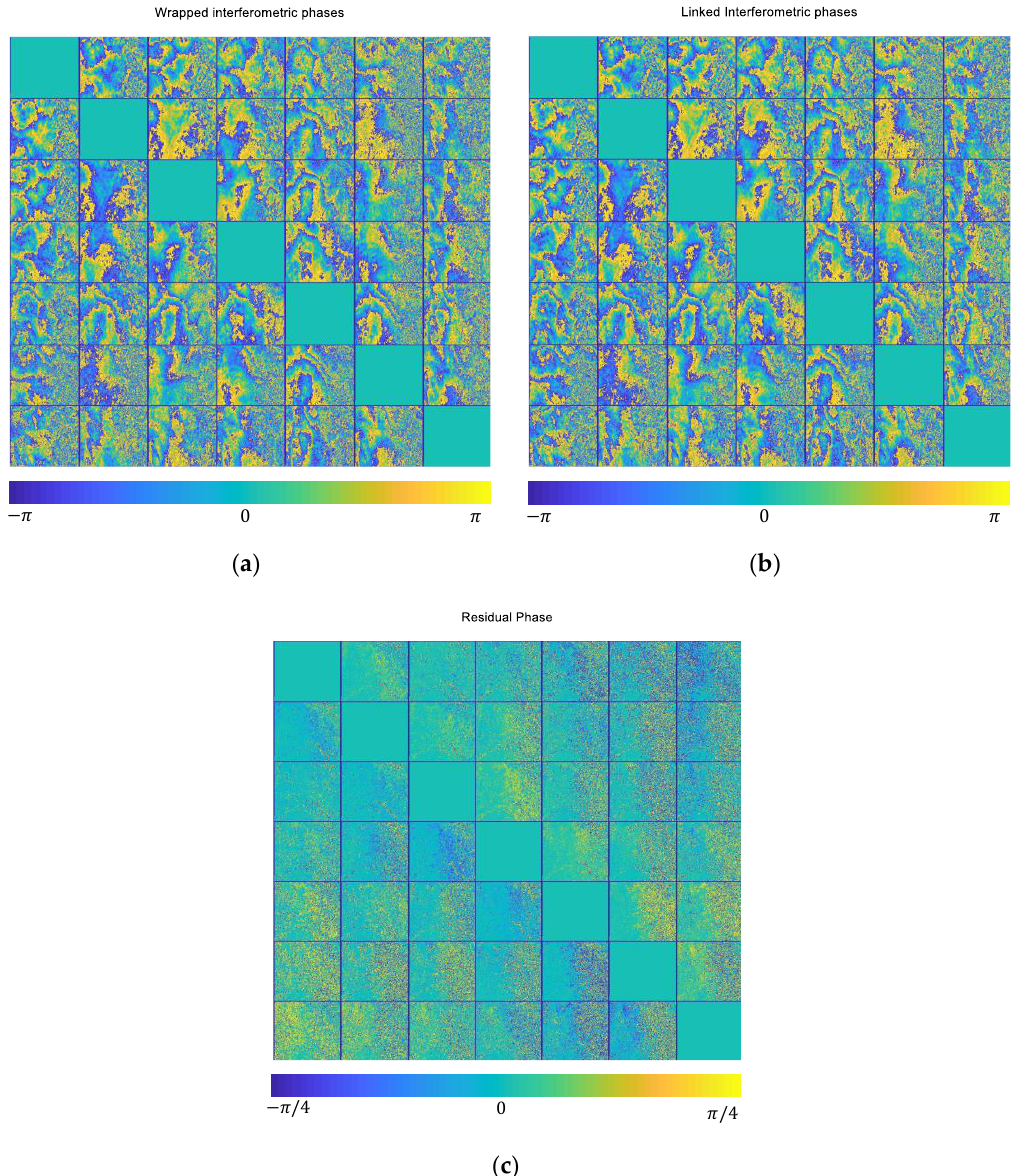
Figure 7. Interferometric phases of a single subswath in the study area. ( a ) Wrapped interferometric phases. The interferometric phase between image k and image l is on the 𝒌 𝒕𝒉 row and 𝒍 𝒕𝒉 column. ( b ) The reconstructed interferometric phases after phase linking (best rank-1 approximation). ( c ) The residuals between the two.